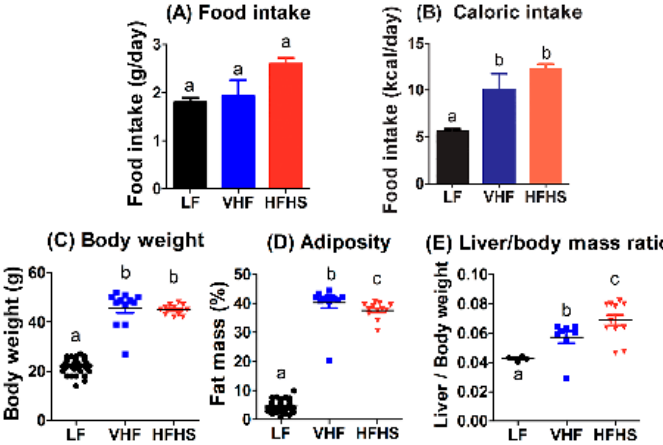
Figure 1. Diet effects on food intake, body weight, and adiposity. Male C57BL/6J mice were fed low fat (LF), very high fat (VHF), or moderately high fat with excess sucrose (HFHS) diets for 12 weeks. Food intake was determined over a 7-day period and the data were reported as grams of food consumed per day ( A ) or calories consumed per day ( B ). Body weight ( C ), adiposity determined based on fat mass as a percentage of body weight ( D ), and liver mass to body mass ratio ( E ) were measured after 12 weeks. The reported data represent the mean ± standard error from 49 LF-fed mice and 12 VHF-fed and 12 HFHS-fed mice. Data groups with letters a are significantly different from data groups with letters b or c at p < 0.01 (1-way ANOVA test with Bonferroni post hoc analysis). Data groups with letters b and c are significantly different at p < 0.001 by Mann–Whitney test.